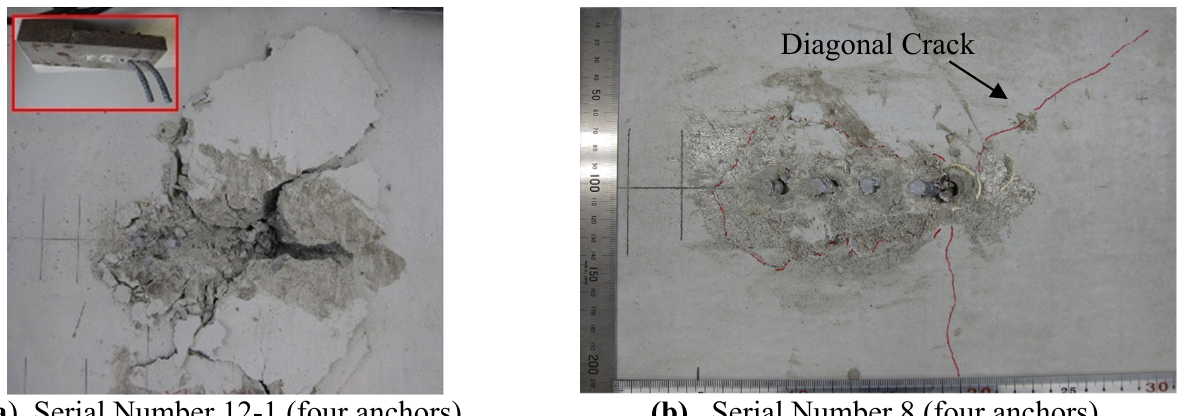
Figure 4. Pry-out Failure and Diagonal Cracks (Sign of Pry-out Failure).